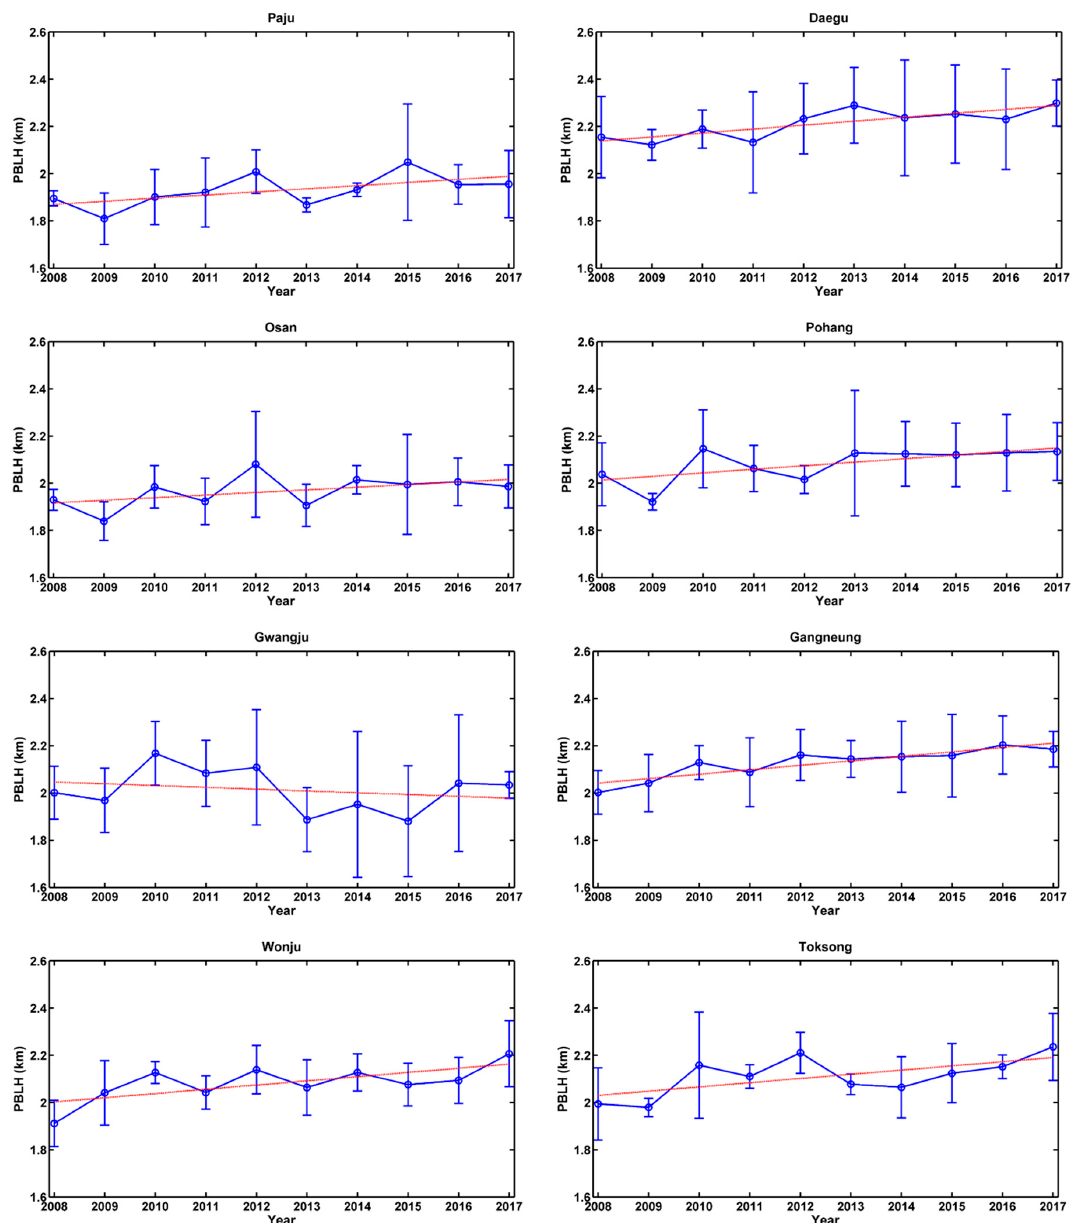
Figure 9. Variability of the maximum PBLH during summer from 2008 to 2017. The error bars and dashed red lines indicate the standard deviation and linear fit of the data, respectively.